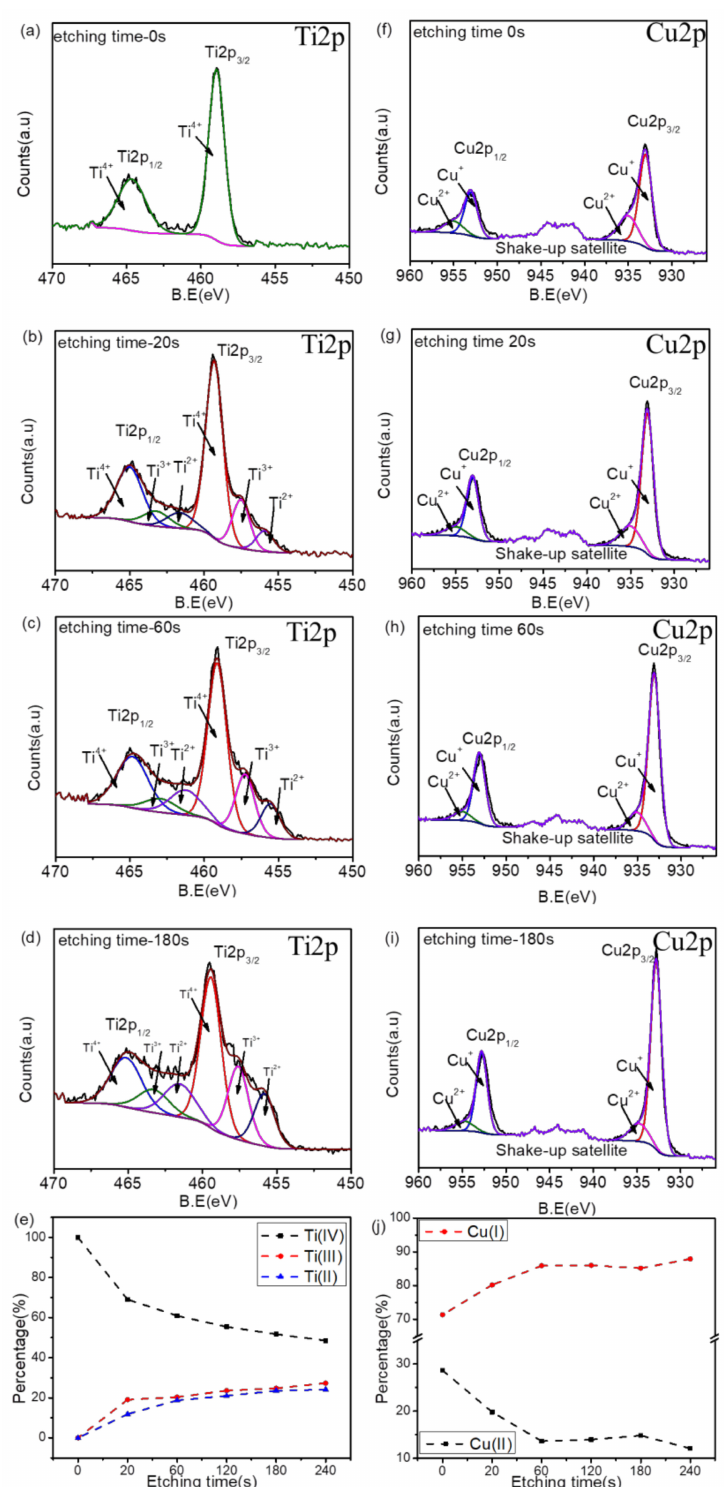
Figure 5. ( a – d ) Ti2p peak fitted spectra of the Ti–Cu coatings deposited on silicon substrates and annealed at 500 ◦ C before (etching for 0 s) and after Ar + ion etching for 20, 60, and 180 s; ( e ) relative area (%) of Ti (IV), Ti (III), Ti (II)) in Ti2p spectra of the Ti–Cu coatings annealed at 500 ◦ C before and after etching; ( f – i ) Cu2p Peak fitted spectra of the Ti–Cu coatings deposited on silicon substrates and annealed at 500 ◦ C before (etching for 0 s) and after Ar + ion etching for 20, 60, and 180 s; ( j ) relative area (%) of Cu(II) and Cu(I) in Cu2p spectra of the Ti–Cu coatings annealed at 500 ◦ C before and after